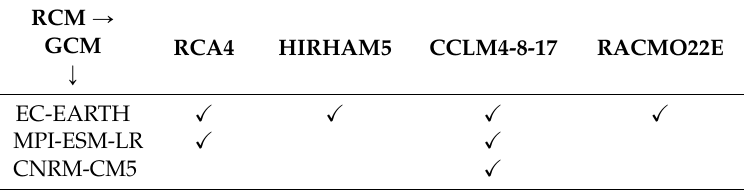
Table 2. A list of applied climate